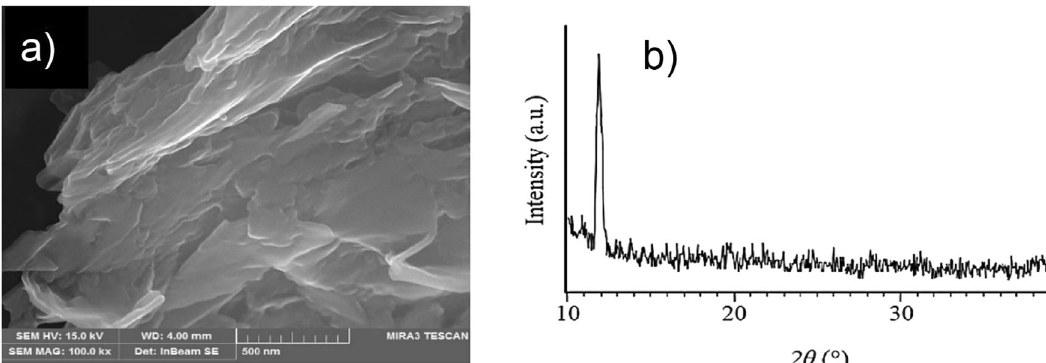
Fig. 1 Characterization of GO. a SEM image. b XRD pattern of GO.